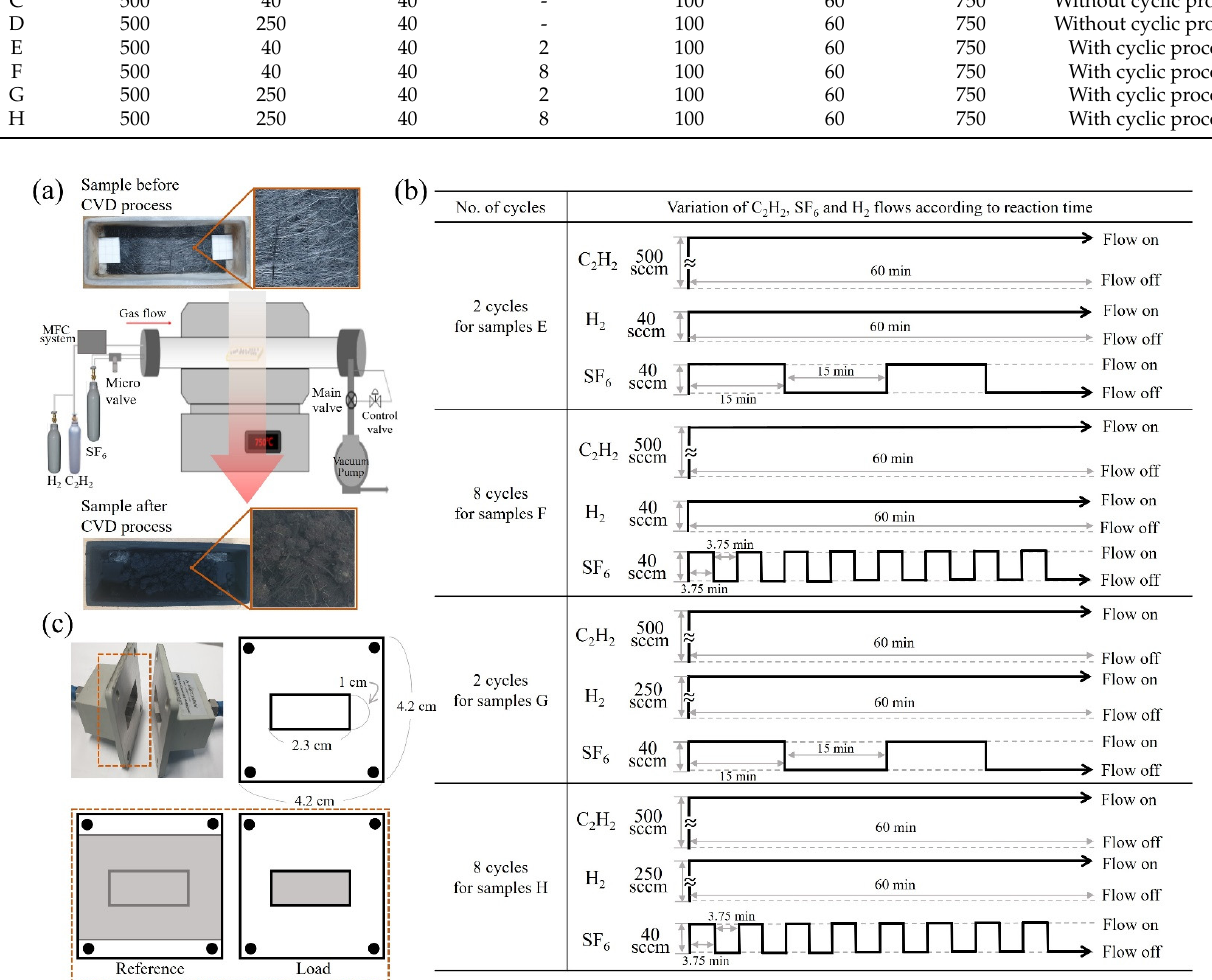
Figure 1. ( a ) Samples before and after thermal chemical vapor deposition (TCVD) process; ( b ) cyclic injection processes of C 2 H 2 , H 2 , and SF 6 for samples E–H; and ( c ) waveguide test holders for vector network analyzer (VNA).